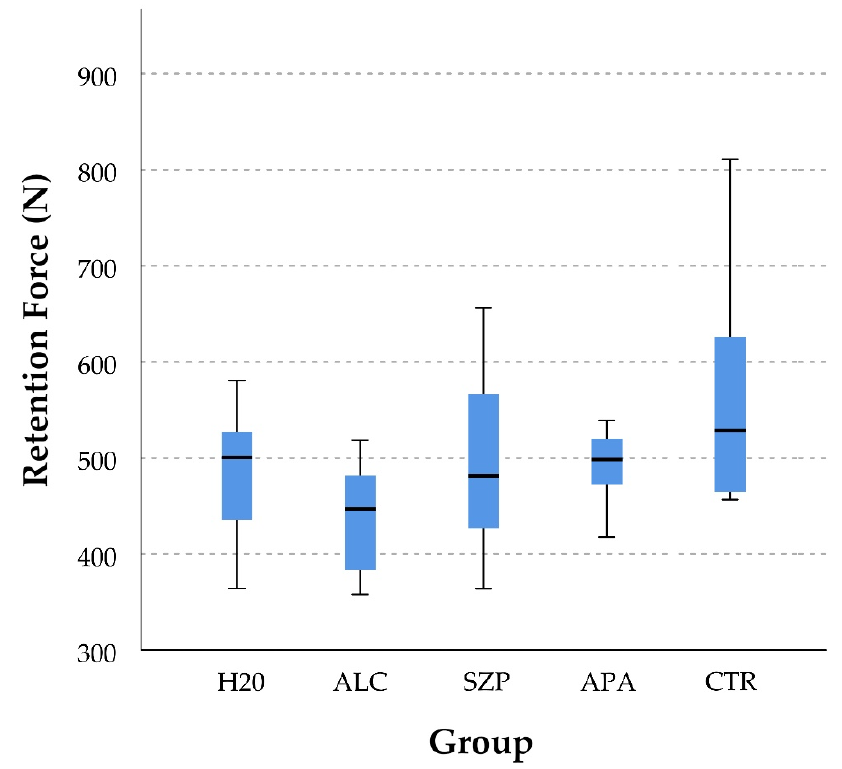
Figure 1. Boxplot of the median (IQR) retention force (N) among the five groups. Table 2. Bonding failures in absolute numbers; means with standard deviations (SD) and medians with interquartile ranges (IQR) of retention force values (N); statistical differences ( p < 0.05) are indicated by different lowercase letters; means of noticeable acoustic click events at the moment of debonding (value = 1) and no click (value = 0). Bonding Failure Retention Force Group Group DebondingNo